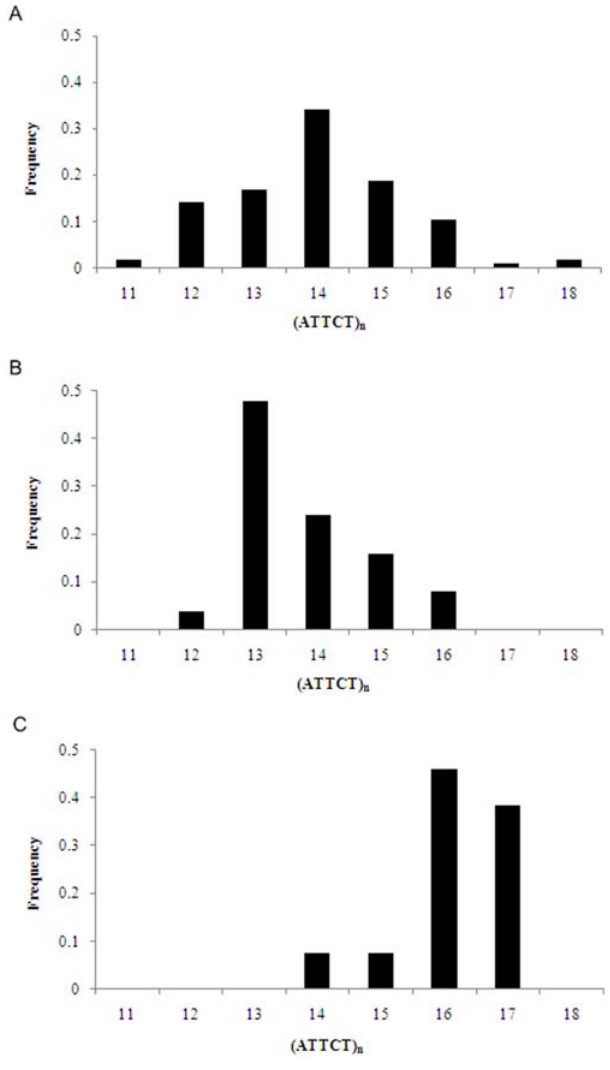
Figure 4. Distribution of Normal Alleles According to SNP Lineages. Repeatdistributionofnormalallelesinthethreemostcommon lineages A. CGGC (n=105), B. AGGC (n=25), and C. AAAC (n=13).